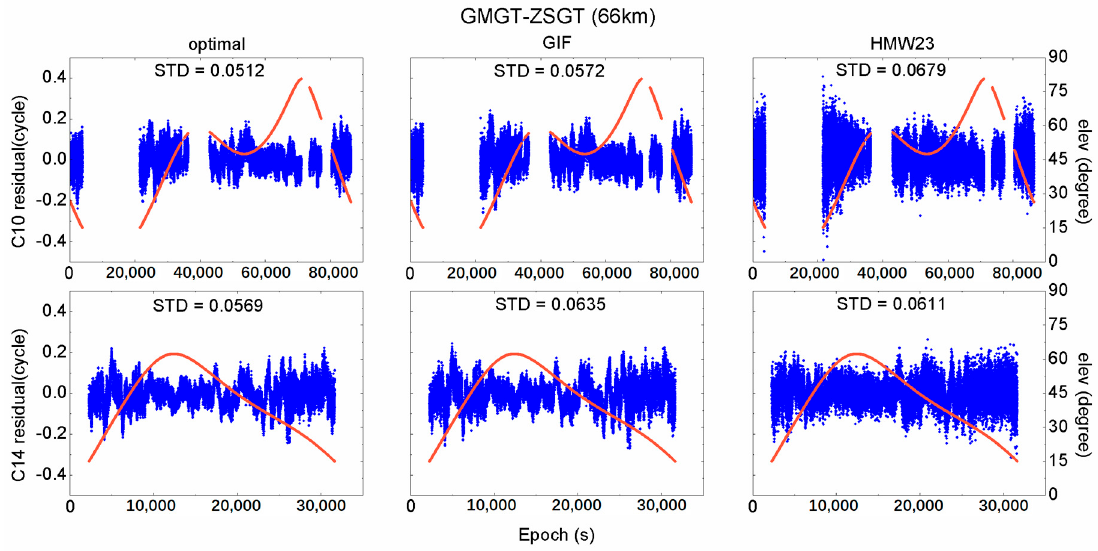
Figure 3. Comparison of ambiguity residuals and the corresponding standard deviations of optimal , GIF , and HMW23 combinations for the medium-long baseline (66 km).